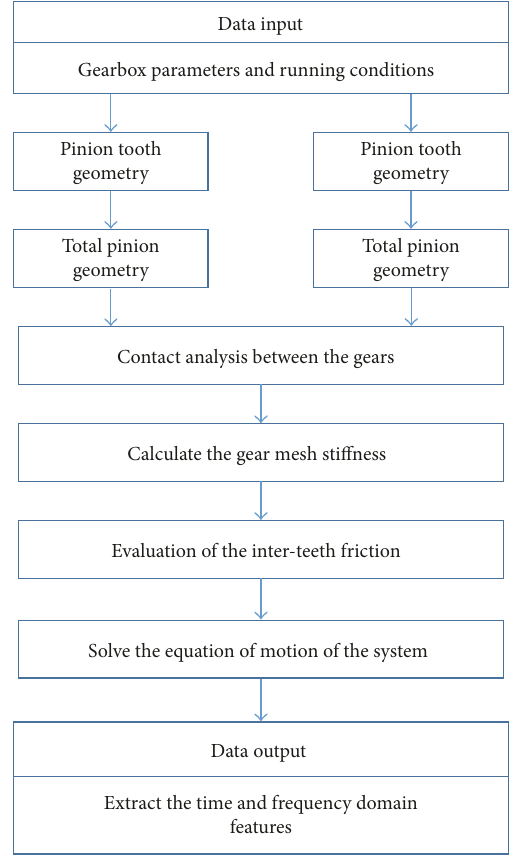
Figure 2: The overall organigram for the code